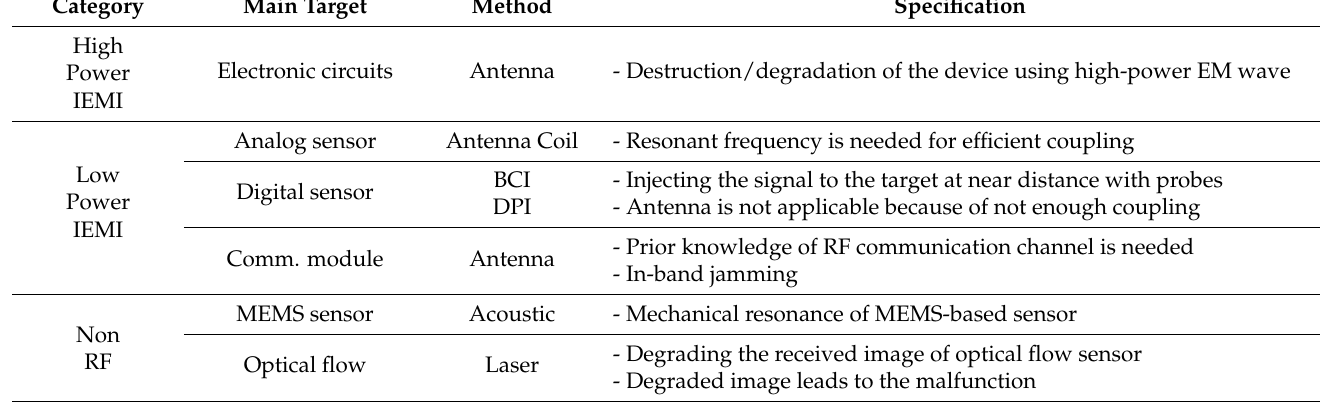
Table 1. Categorization of intentional electromagnetic interference.